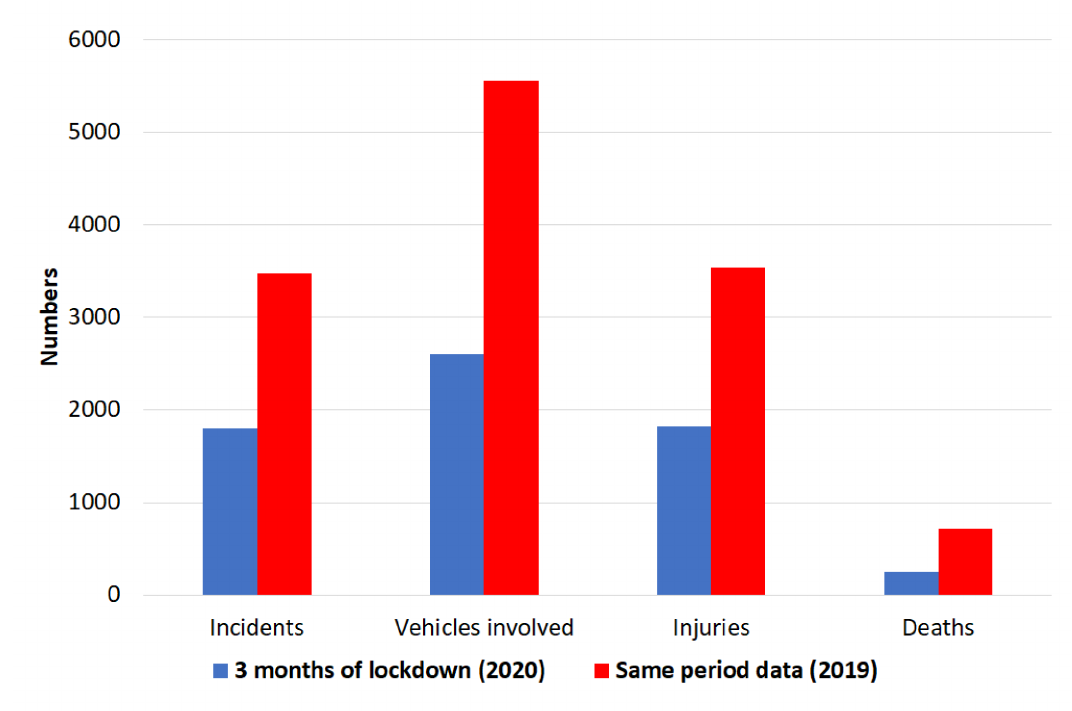
Figure 3. Comparison of incidents of road crashes, injuries and deaths during the 3 months of COVID-19 lockdown and the same period in